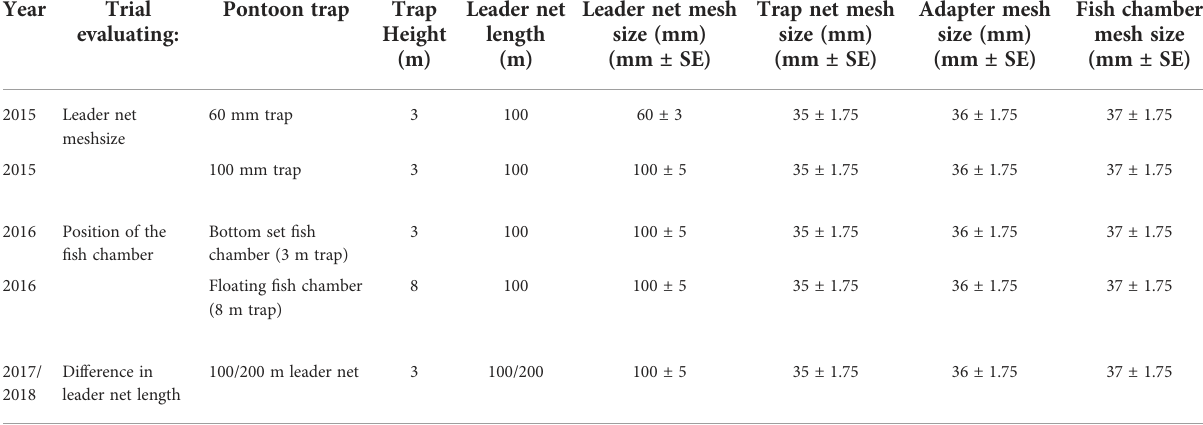
TABLE 1 Parameters for the different trap parts and running title used in the trials. Mesh sizes indicate the distance between center-knots. Year Trial